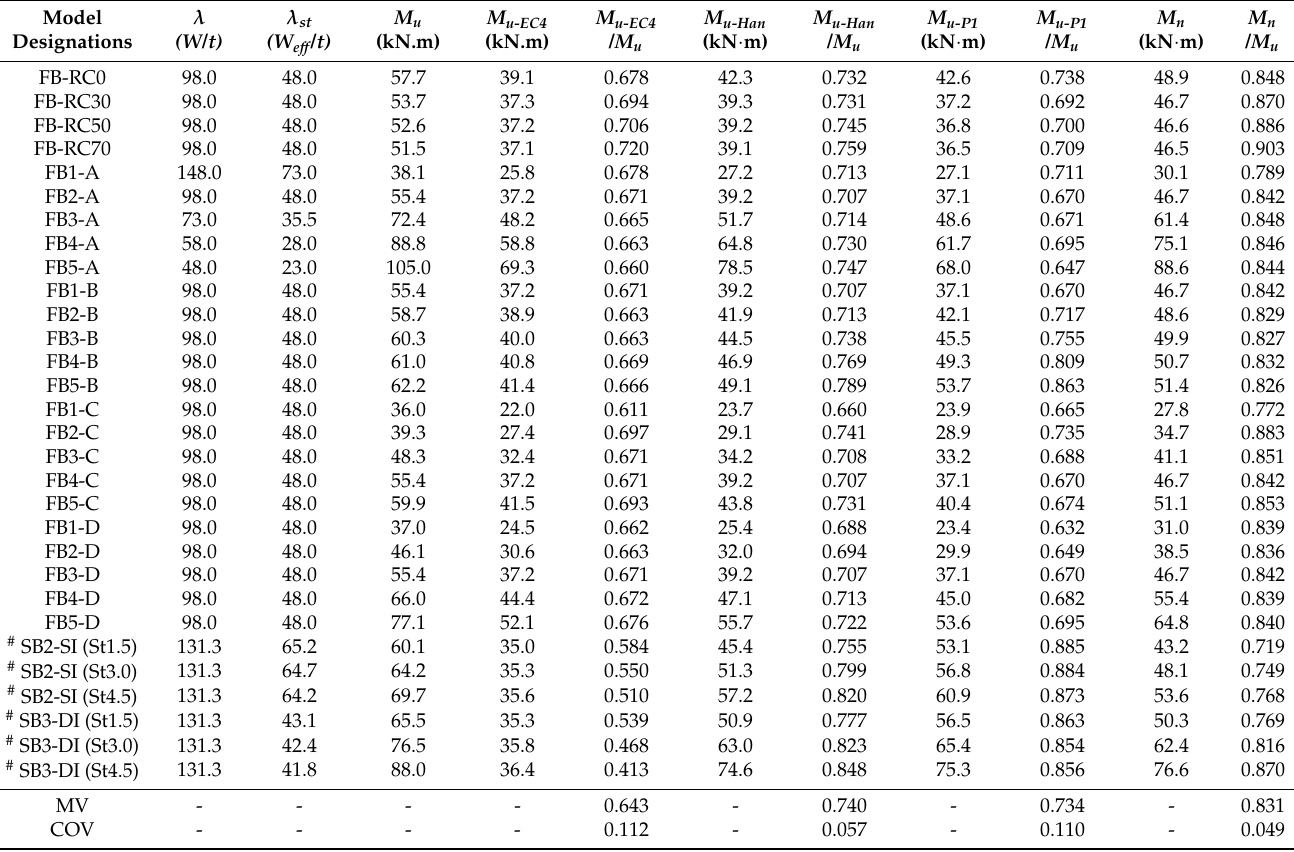
Table 4. Verification of the obtained M u values of the tested specimens and analysed FE models. Model